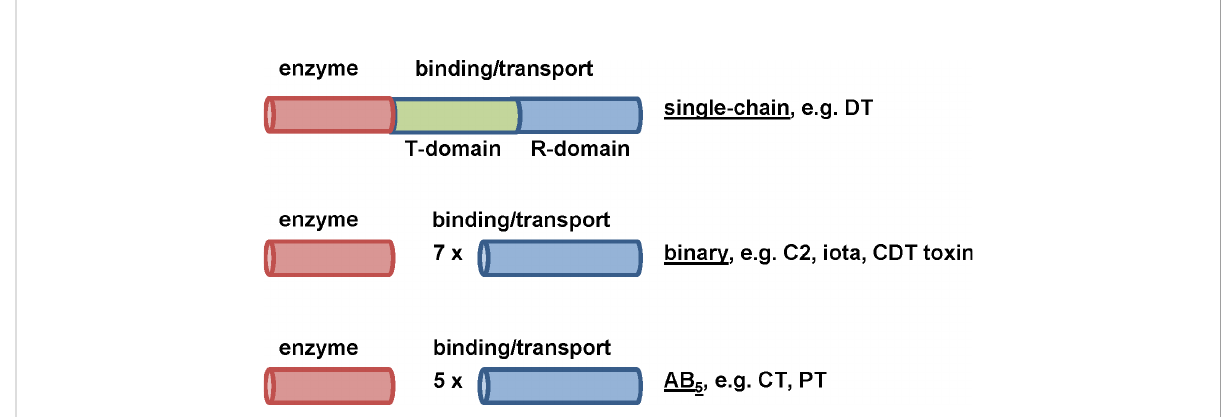
FIGURE 1 Different structures of bacterial AB-type toxins. Single-chain toxins consist of one single polypeptide chain and both domains, A-and B-domain, are located on this protein. For DT, the binding/transport B-domain can be subdivided in two further functional domains. The R-domain is responsible for receptor-binding and the T-domain is required for translocating the enzyme domain into the cytosol. Binary toxins express their functional domains on two separate proteins, then called A- and B-components. In solution or at the cell surface, seven B-components form a ring-shaped homooligomer to which the A- component binds. AB 5 -toxins such as CT or PT consist of one A-subunit and fi ve B- subunits. The B-subunits form homo- (CT) or hetero- (PT) oligomers which non-covalently interact with the A-subunit. In contrast to binary toxins, formation of the AB 5 -holotoxin takes place in the periplasm of the producing bacteria, i.e. before the toxin is